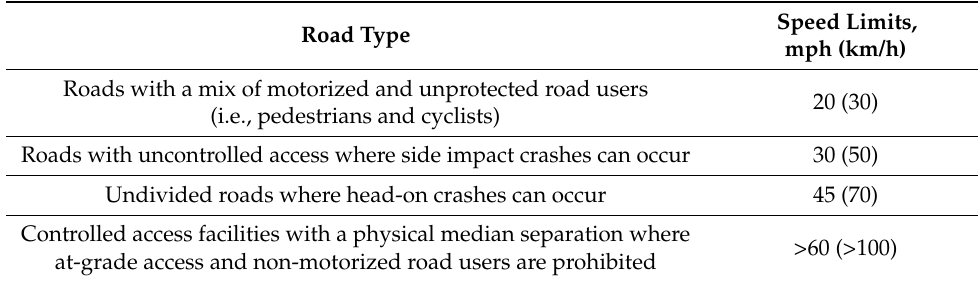
Table 3. Speed limits for injury minimization.